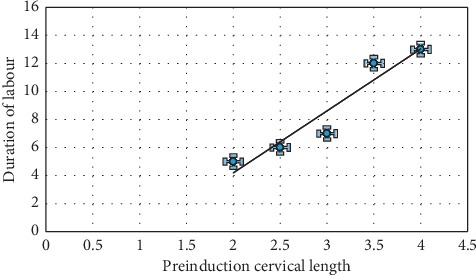
Association between induction delivery interval and sonographically measured cervical length.